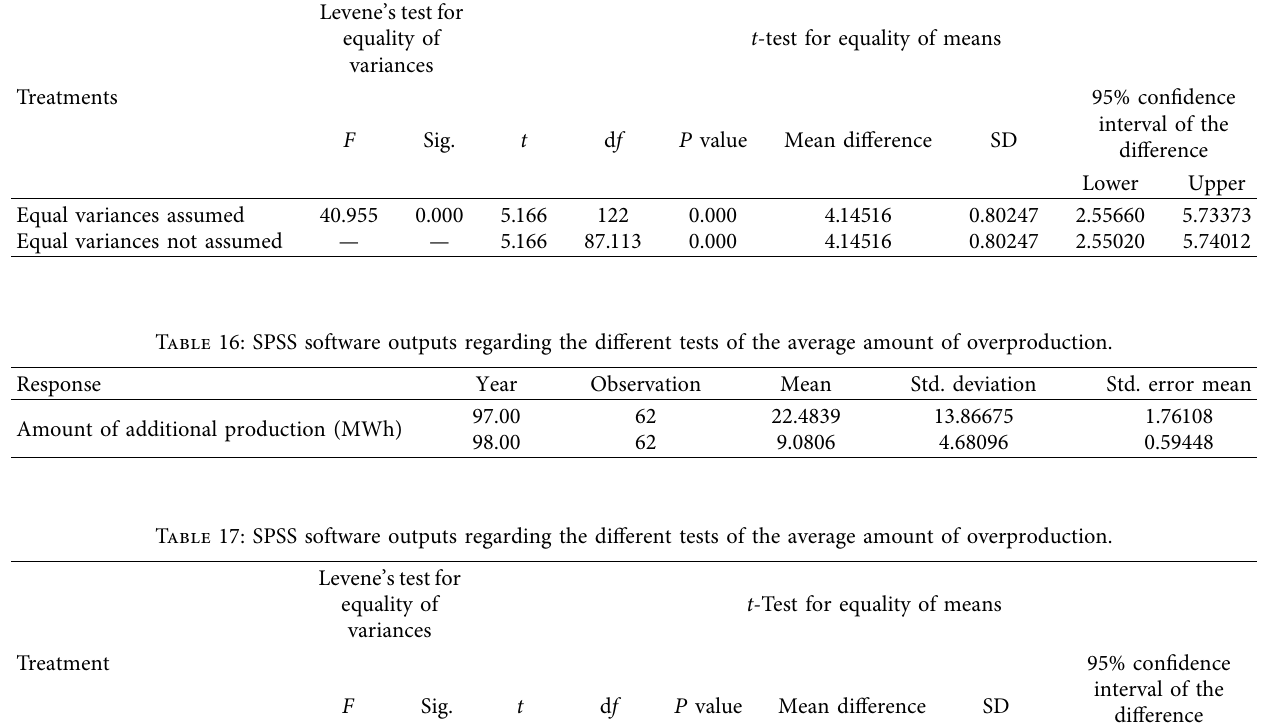
Table 15: SPSS software outputs for testing the difference in the average number of blackouts.